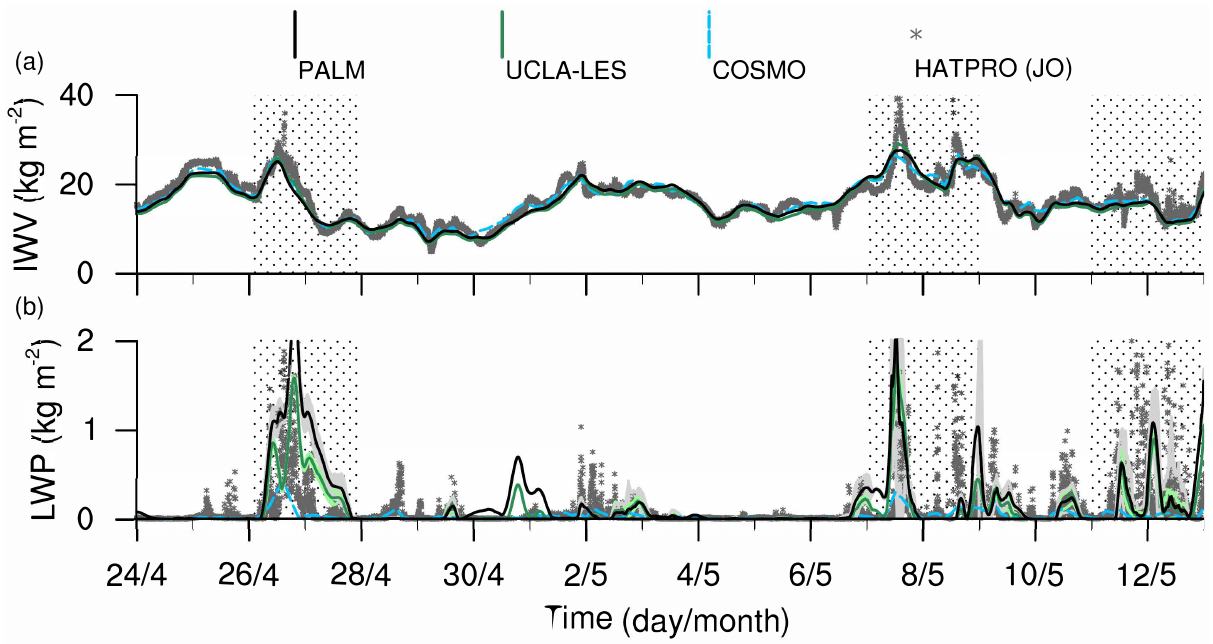
Figure 8. Temporal evolution of integrated water vapor (IWV) in (a) and liquid water path (LWP) in (b) . An overview of the measurements and abbreviations is given in Table 1. Gray and green shading in (b) denote twice the standard deviation of LWP in PALM and UCLA-LES, respectively. Stippled highlighting as in Fig.